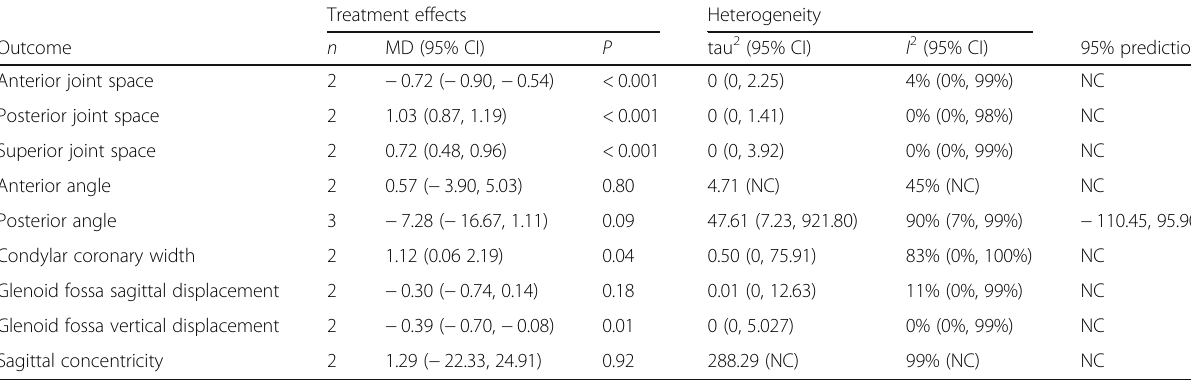
Table 4 Results of random effects meta-analyses